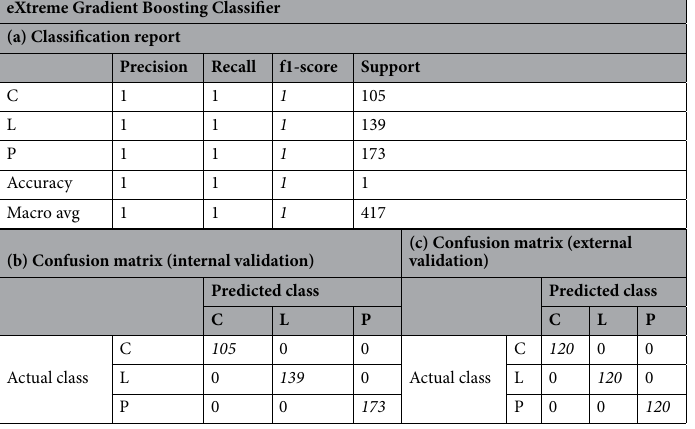
Table 4. (a) Classification report, (b) confusion matrix for internal validation, and (c) confusion matrix for external validation resulting from the XGBoost algorithm.